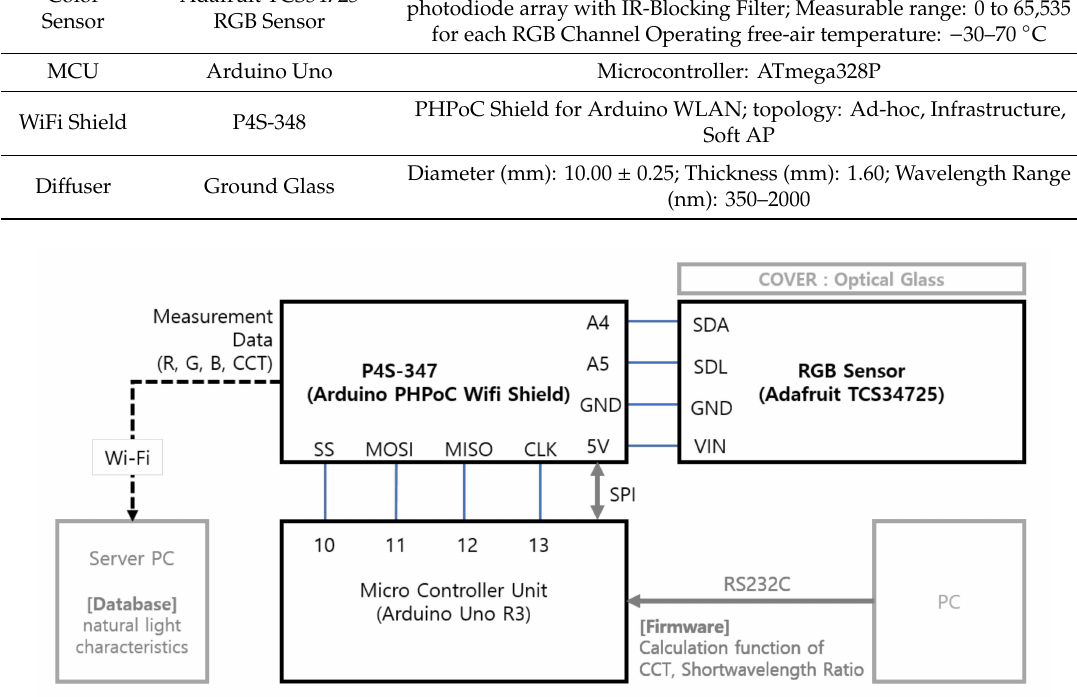
Figure 3. RGB-sensing device (block